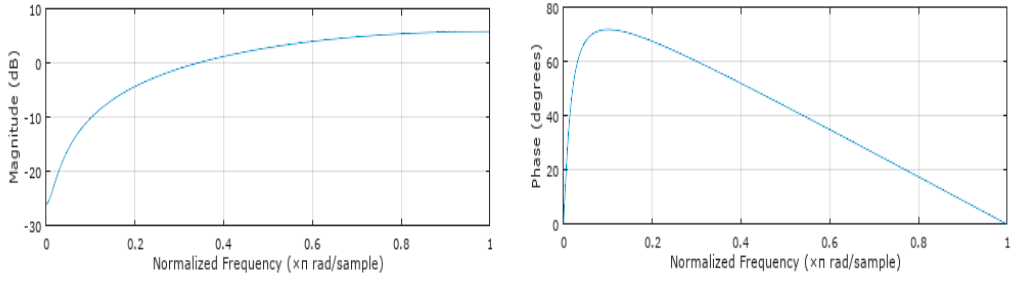
Figure 2. Magnitude and phase response of the pre-emphasis filter.